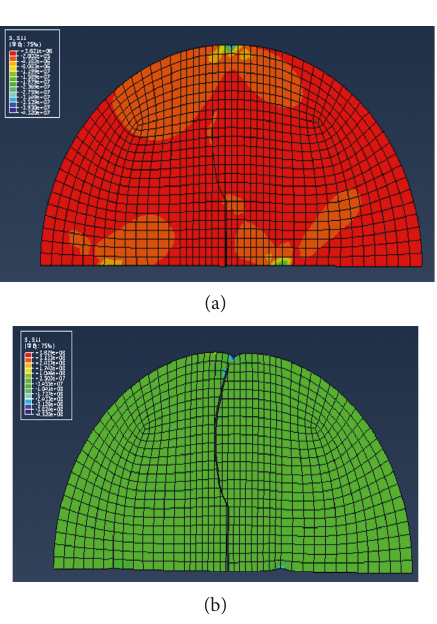
Figure 8: Distribution of stress and crack propagation process.